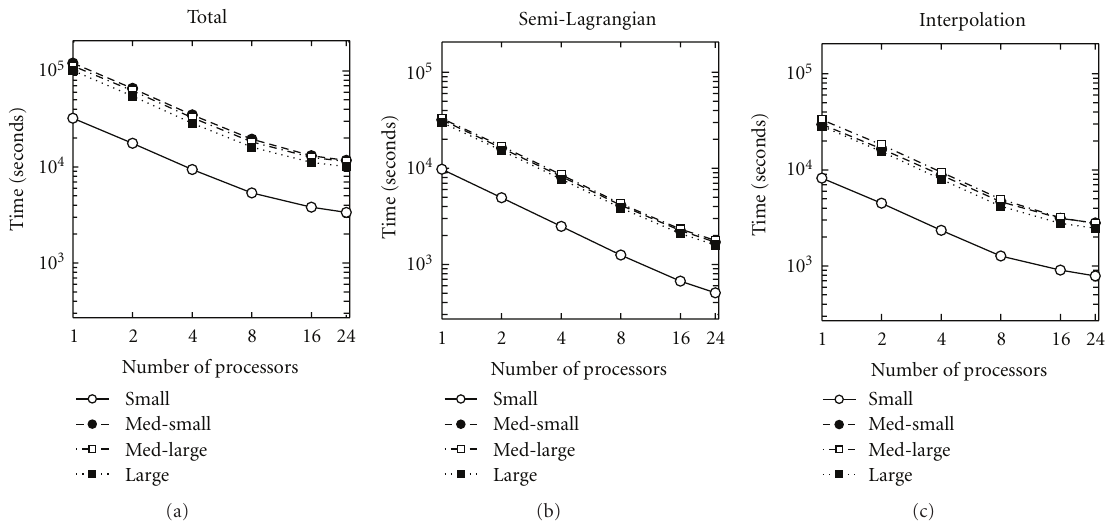
Figure 3: Time spent on computations for the four patients examined, plotted on a log-log axis. (a) Total time, (b) time in semi-Lagrangian advection, (c) time in image interpolation. Note that in (a) med-small takes the longest, followed by med-large, large, and small. In (b) and (c), the order of the first two is reversed.